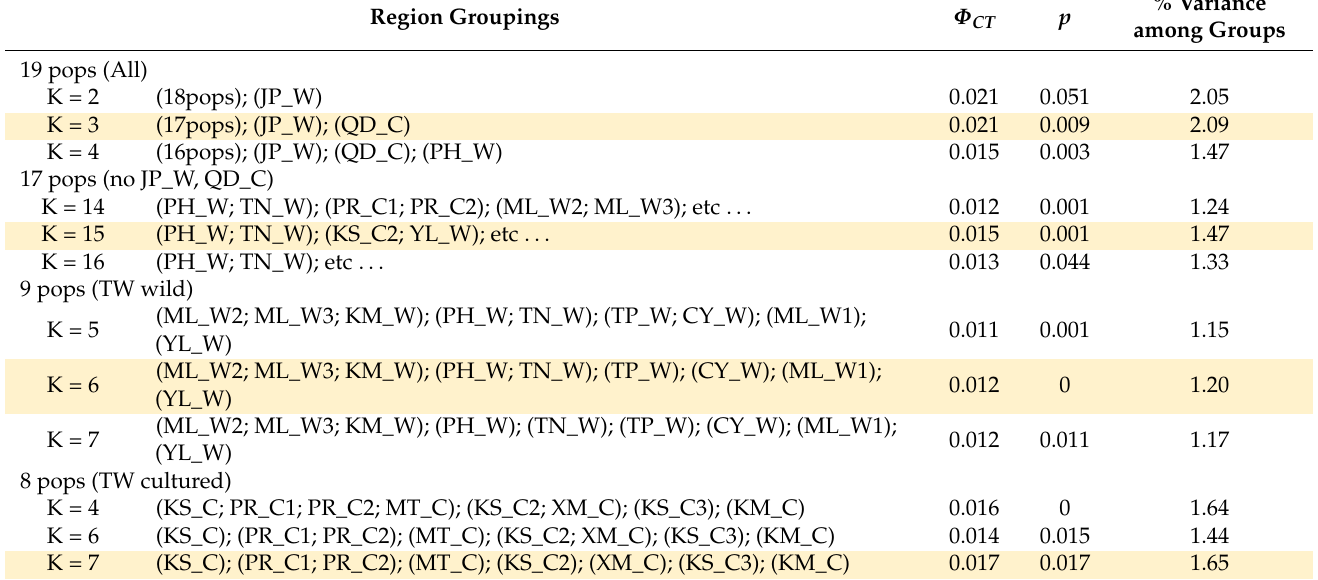
Table 8. Hierarchical AMOVA of 19 black sea bream populations collected from hatcheries and the wild, with analysis performed using SAMOVA. Region Groupings Φ CT p